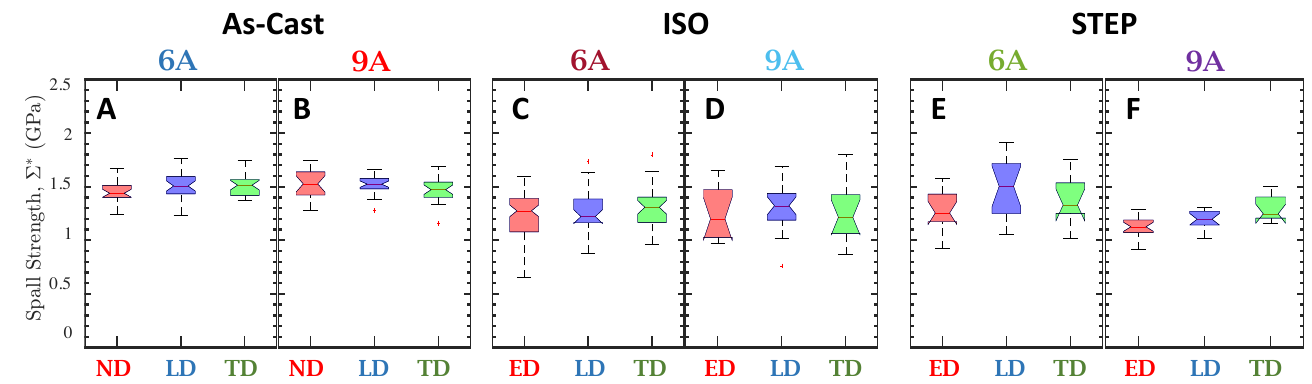
Figure 5. Orientation and sample-based spall strength statistical distributions. Orientation-based box-plots showing the relative distributions for the ND/ED, LD, and TD directions (left to right) for ( A ) 6A As-Cast, ( B ) 9A As-Cast, ( C ) 6A ISO, ( D ) 9A ISO, ( E ) 6A STEP, and ( F ) 9A